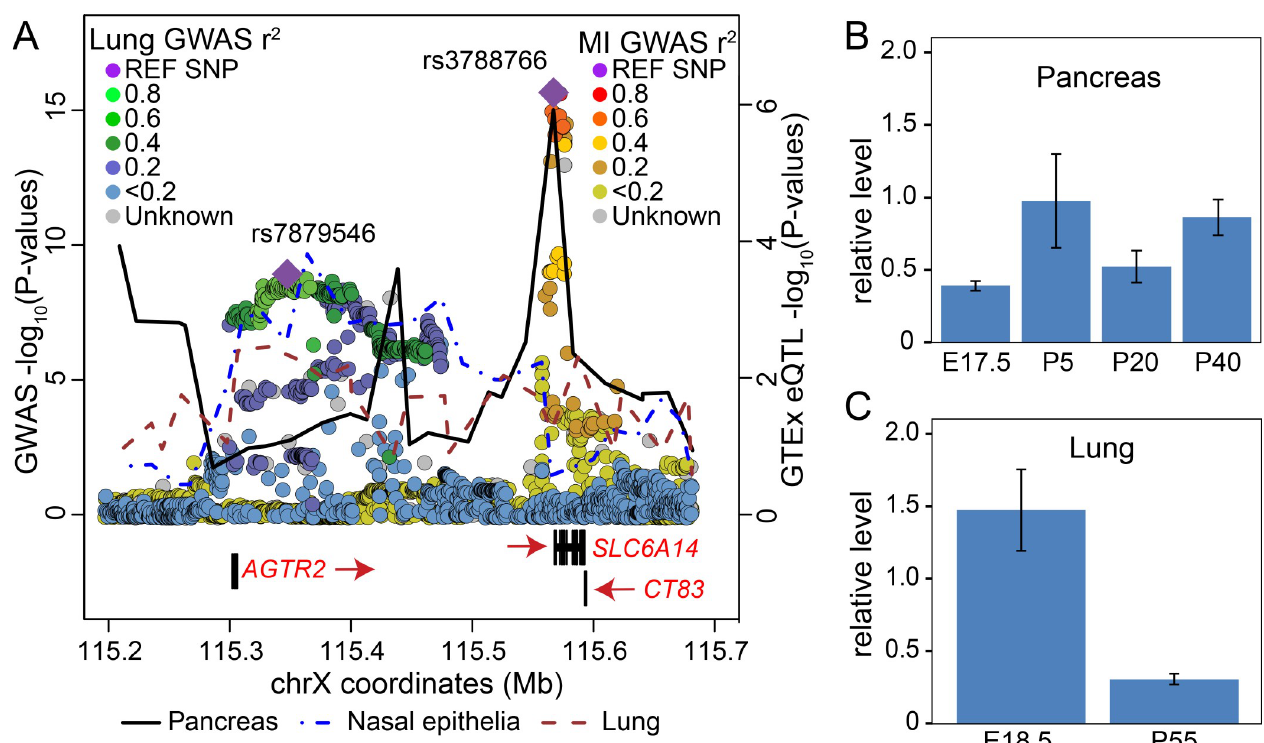
Fig 3. SLC6A14 meconium ileus and lung association and gene expression profiles point to cis -regulation that is distinct in pancreas and lung. (A) Overlay of p-values (on the–log 10 scale) from the meconium ileus GWAS (red/yellow palette of colored dots; this study), from the previous lung function GWAS (green/blue palette of colored dots; [41]) and from the GTEx eQTL for association between SNPs and SLC6A14 expression (lines, derived as for Fig 2) for tissues of interest. (B) and (C) Slc6a14 gene expression levels measured by RT-PCR of RNA from C57BL6/J mice (n = 4) from pancreas (B) and lung (C); expression is shown relative to Gusb at gestational (E) or post-natal (P) days indicated. (blue dashed line) and pancreas (black solid line) tissues appeared to coincide, respectively,